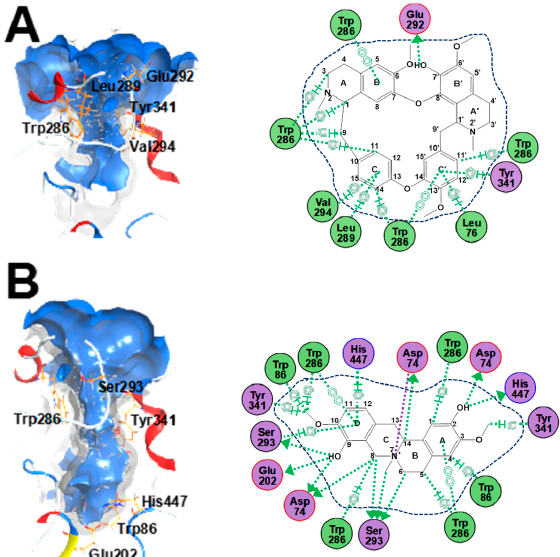
Figure 6. The binding modes of fangchinoline and cyclanoline with AChE (Protein Data Bank (PDB) code: 4EY7). ( A ) The three-dimensional (3D) surfaces and interaction maps of fangchinoline with AChE (left) and the 2D interaction of fangchinoline with AChE (right). ( B ) The 3D surfaces and interaction maps of cyclanoline with AChE (left) and the 2D interaction of cyclanoline with AChE (right). The dotted arrow from the structure to amino-acid residues represents the sidechain donor. The arene symbol represents π bond interactions with other chemical